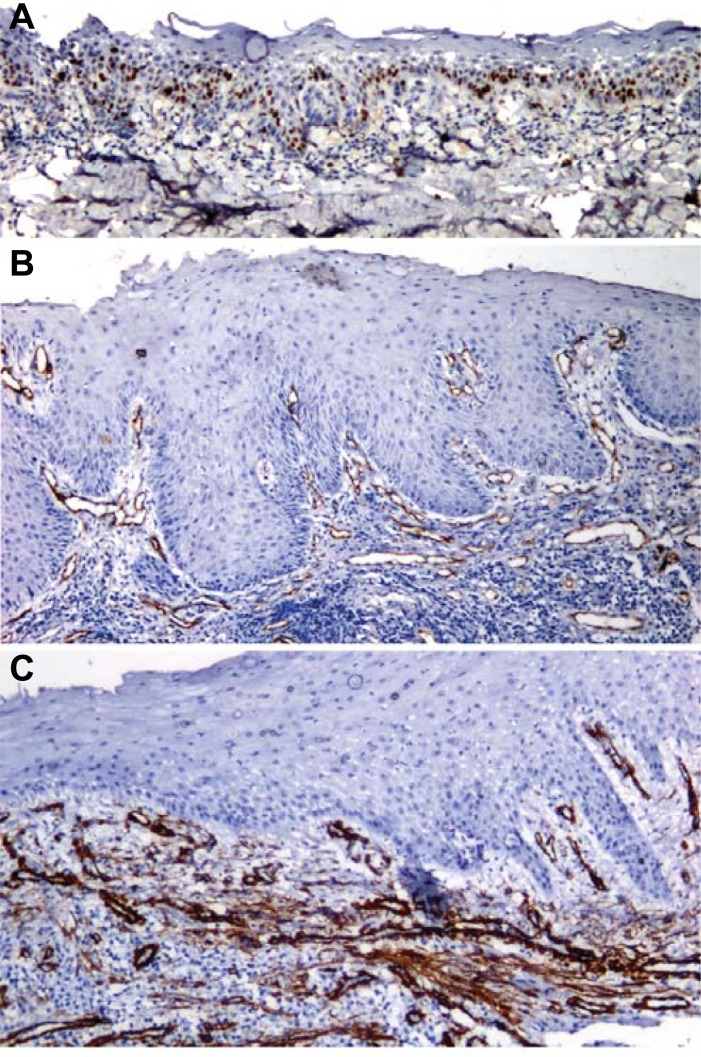
Photomicrograph of HRED showing a) Ki67 labeling index, b) CD105 (Neoangiogenesis) and c) α-SMA Expression (100X).